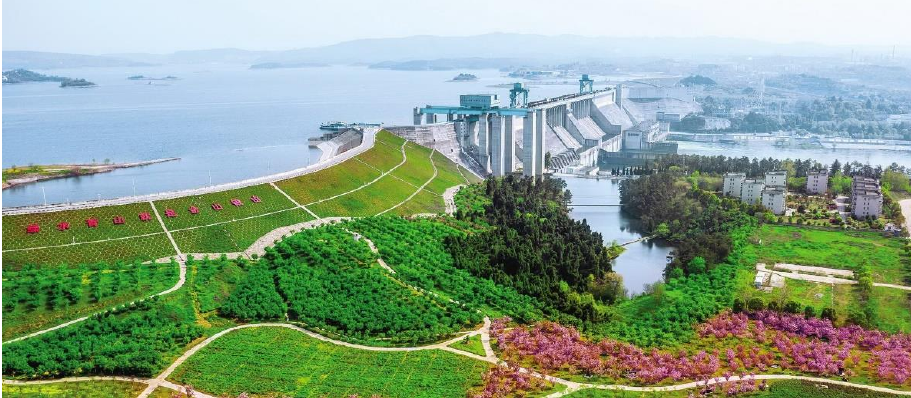
Water 2022 , 14 , x FOR PEER REVIEW Figure 1. The schematic diagram of the layout of the Danjiangkou water control project.